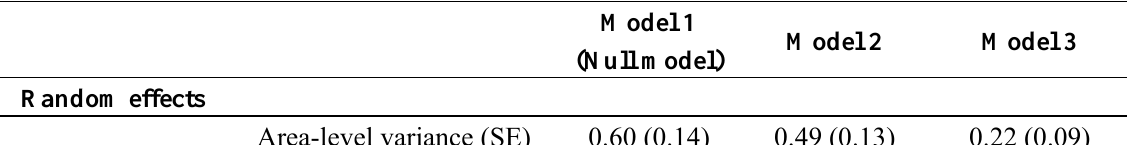
Table 3. Association of self-rated good oral health with individual and community-level characteristics determined by multilevel logistic